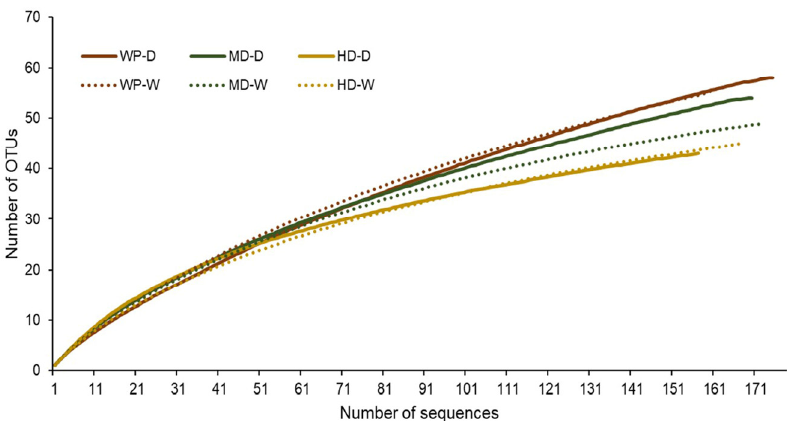
Figure 2. Rarefaction curves of a number of fungal OTUs found in samples of Quercus deserticola litter from forest sites with increasing levels of disturbance (well preserved: WP; moderately disturbed: MD; heavily disturbed: HD) in central Mexico in the dry (D) season and rainy (W) season.